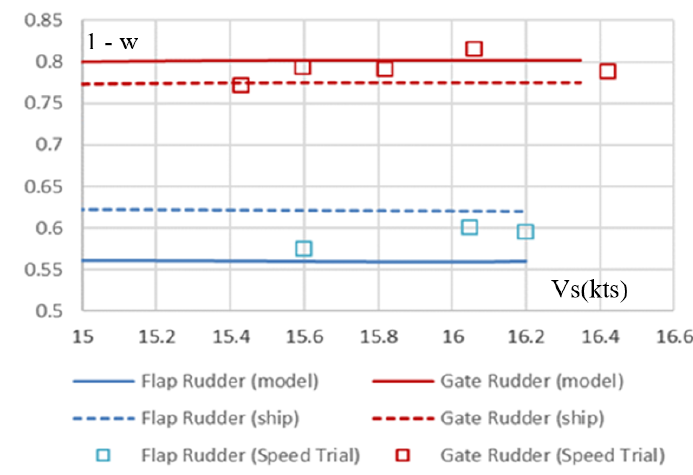
Figure 14. Effect of drag and lift correction on predicted and measured (speed trials) effective wake.